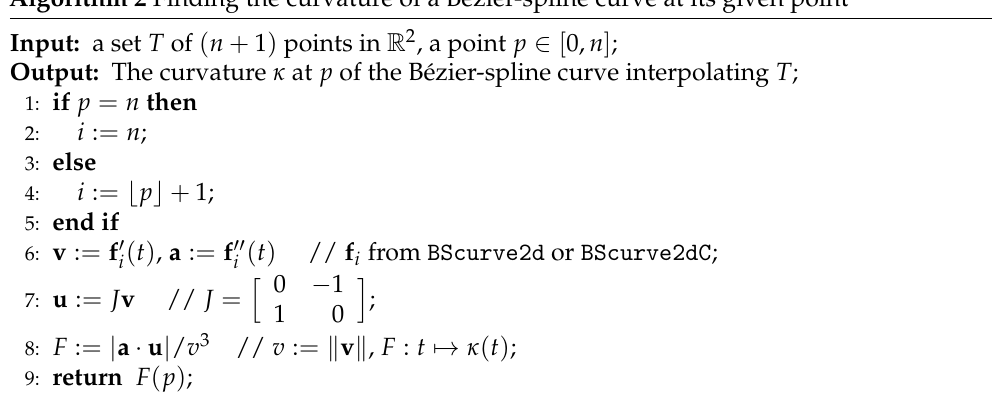
Algorithm 2 Finding the curvature of a Bézier-spline curve at its given